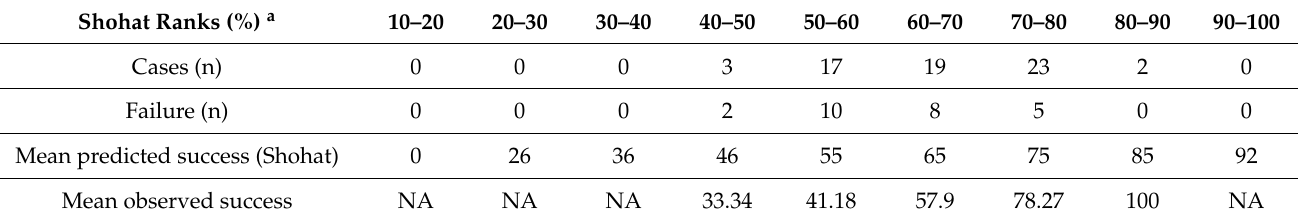
Table 3. Prediction accuracy. Mean predicted success vs. mean observed